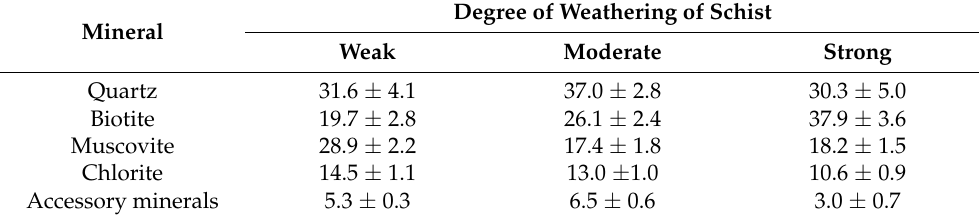
Figure 3. Thin sections of the weakly ( a ) and strongly ( b ) weathered schist samples. ‘Q’, ‘C’, ‘B’, and ‘M’ denote the quartz, chlorite, biotite and muscovite grains, respectively, and the pores and foliation appear in black. Table 3. Mineral composition of the schist by modal analysis. The values are expressed as mean ± error (in percentage) of three independent thin sections from three subsamples from each category.